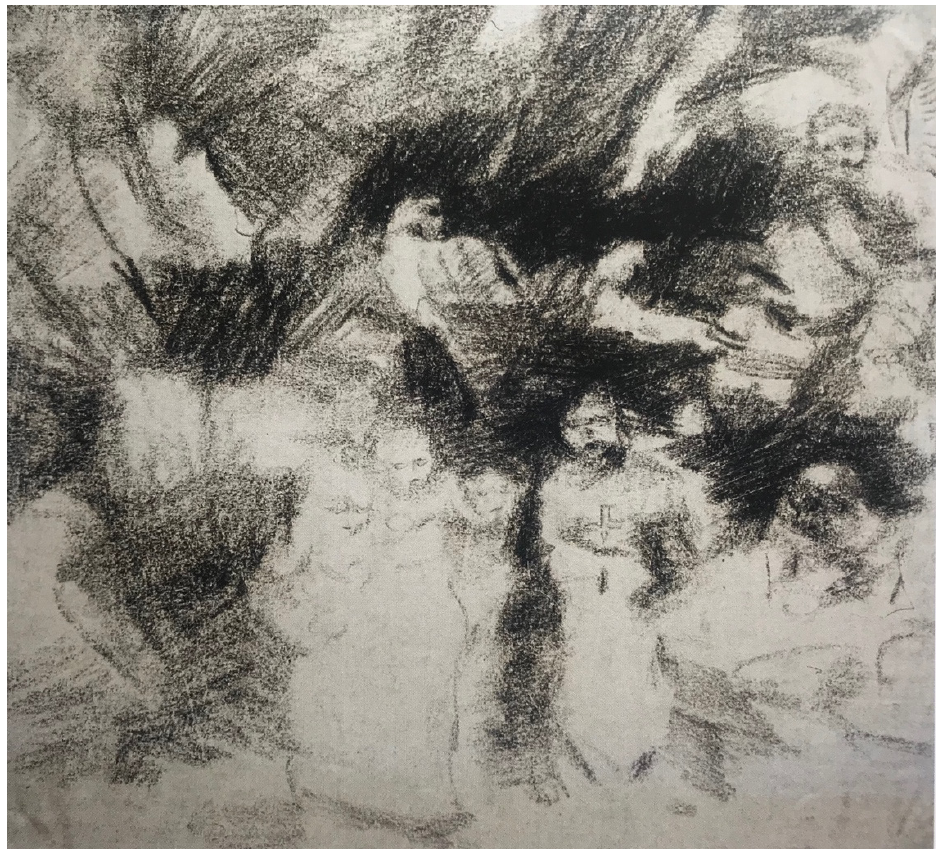
Figure 9. Vasily Chekrygin, The Raising of the Dead , 1922, pencil and charcoal on paper, collection of K.I. Grigorishin, Moscow.